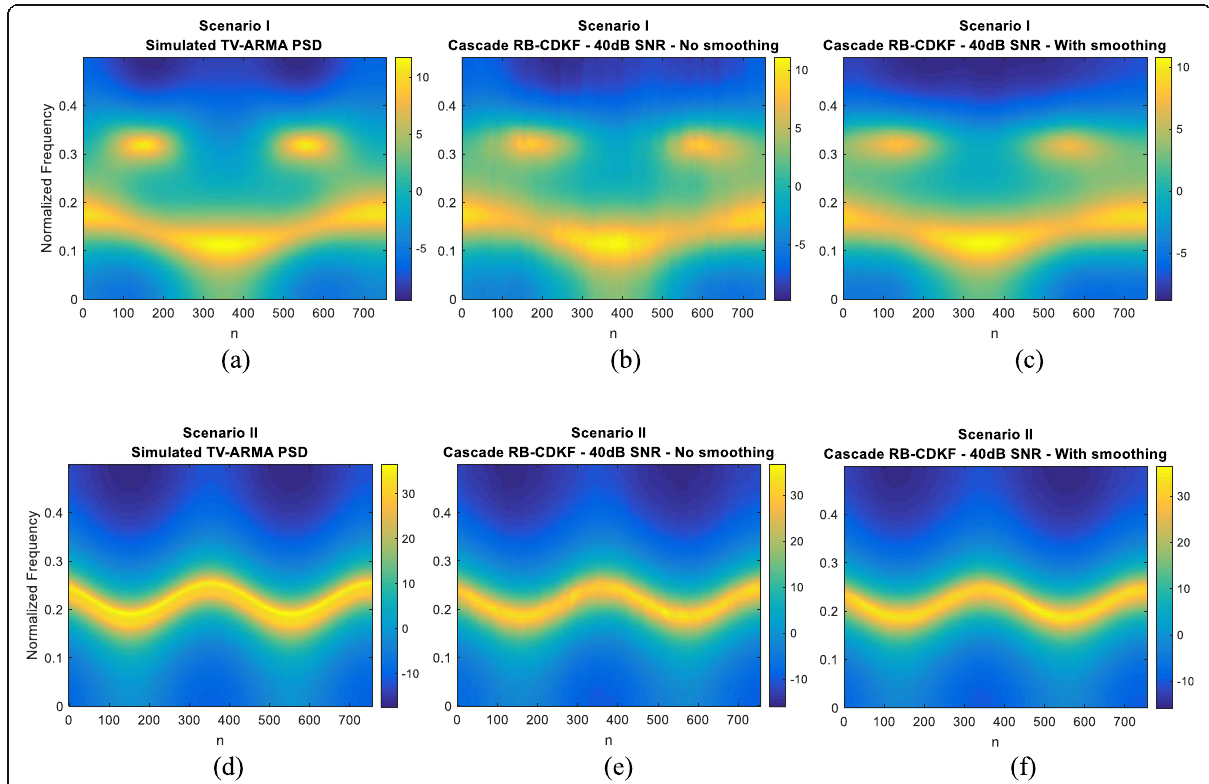
Fig. 6 Simulated ( a , d ) and estimated ( b , c , e , f ) TV PSDs (averaged over all 30 realizations) for Scenario I (upper panel) and Scenario II (bottom panel), under 40 dB SNR and either with (right panel) or without (middle panel) smoothing. The estimation technique used was RB-CDKF combined with the cascade-form ARMA